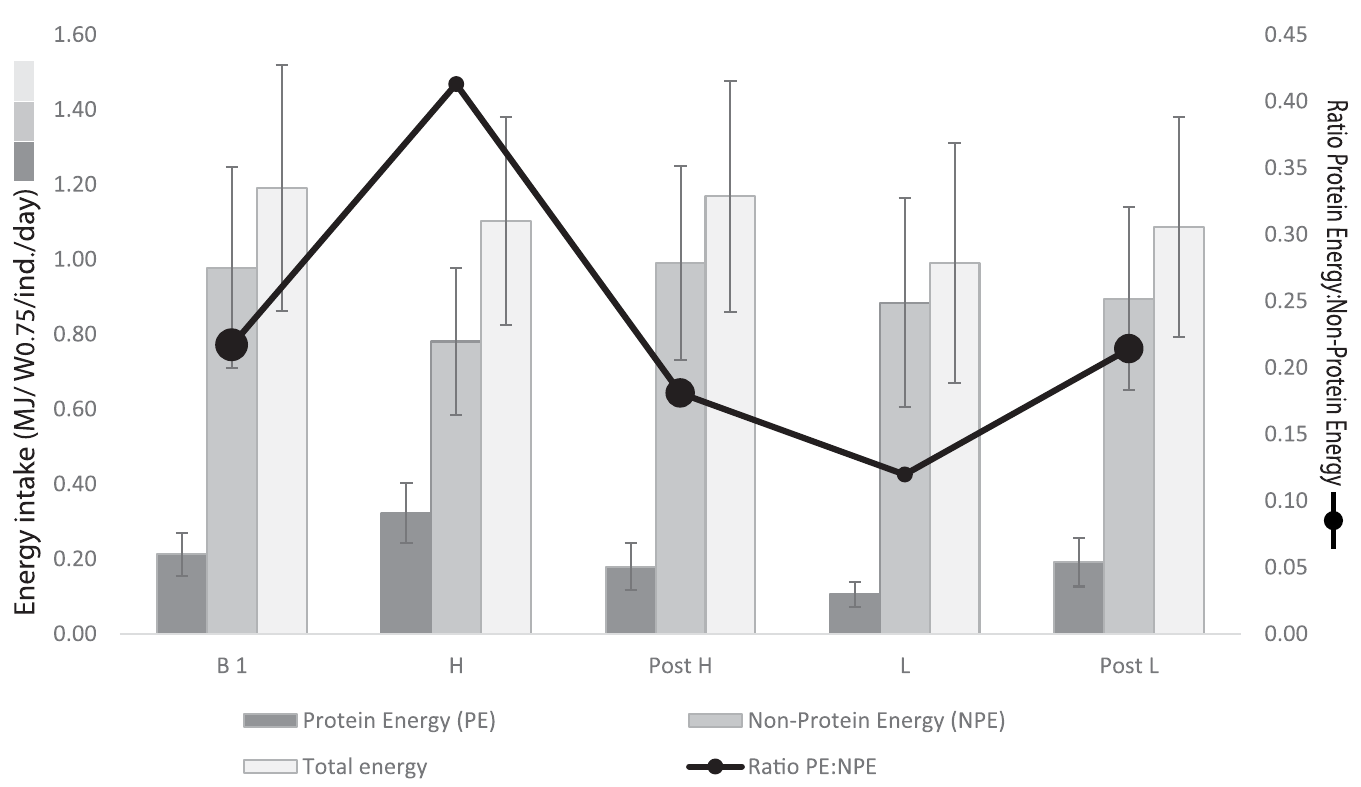
Fig 4. Mean daily intake of protein energy (PE, dark bars, y 1 ), non-protein energy (NPE, medium dark bars, y 1 ) and total energy (light bars, y 1 ) by adult moose ( ± 1 stand. dev) during each of the five experimental phases (high protein (H), low protein (L), Buffet 1, Post H buffet, Post L buffet). The moose ’ daily intake ratio PE:NPE is shown on the y 2 axis (black dots and lines), with intake during buffet phases indicated by extra-large dots. The moose maintained a similar PE:NPE ratio during each of the three buffet weeks (statistical results in Table 5).